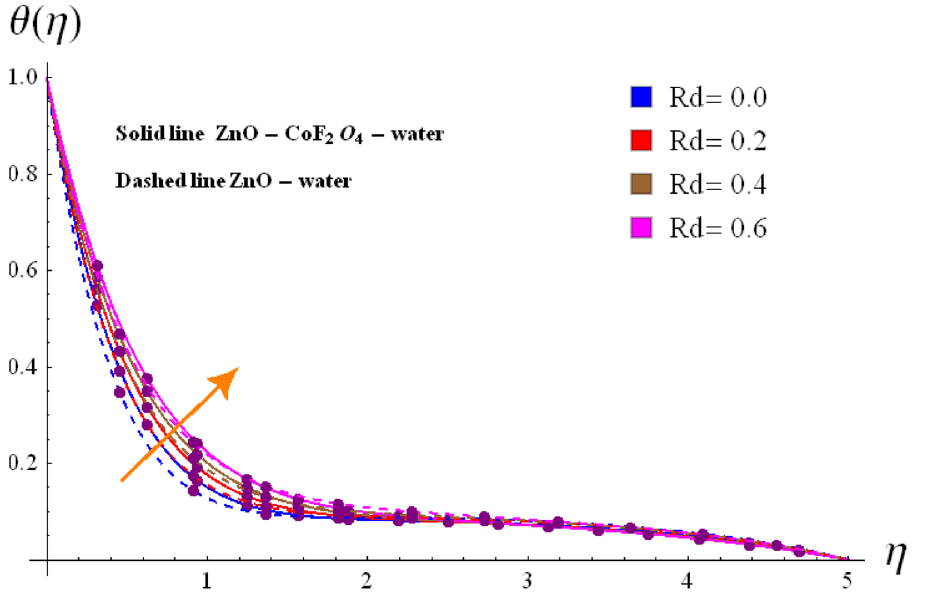
Figure 7. Variation of θ(η) via Rd